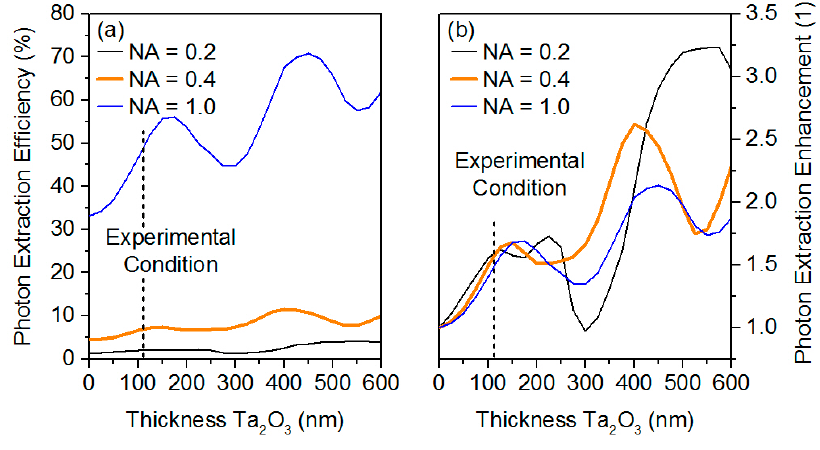
Figure 3. ( a ) Finite element method simulation of the PEE based on solving Maxwell’s equations for a microlens without a backside distributed Bragg reflector (DBR) for numerical apertures of 0.2, 0.4 and 1.0 of the collecting optics as a function of Ta 2 O 5 thickness; ( b ) Photon-extraction enhancement deduced from ( a ) as a function of Ta 2 O 5 thickness.